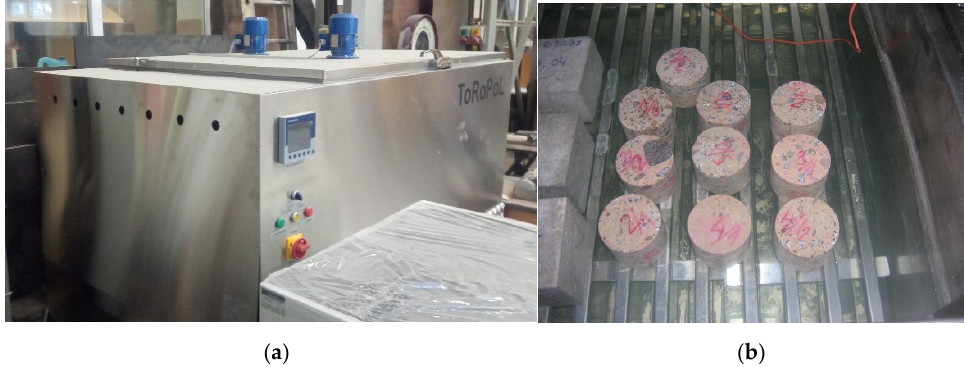
Figure 4. Frost resistance tests: ( a ) view of freezing chamber; ( b ) view of concrete specimens inside the freezing chamber.